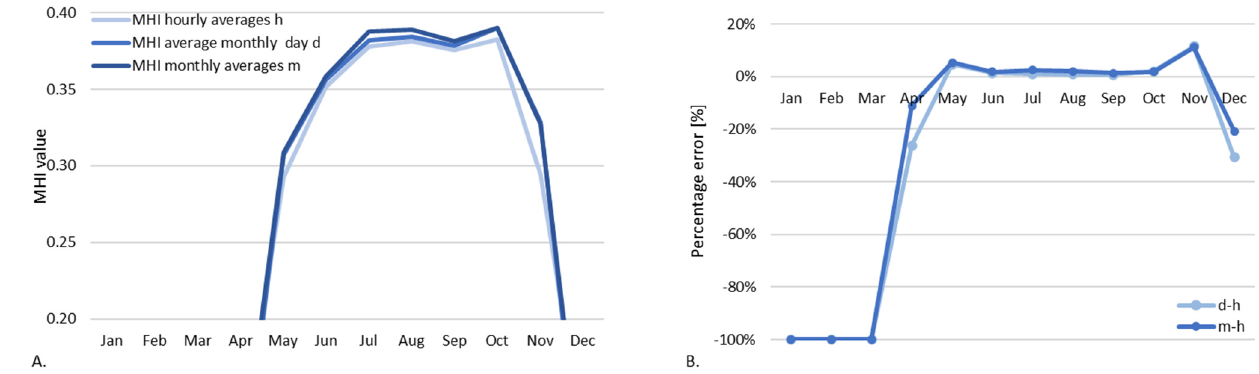
Figure 18. Paris MHI values ( A ) and percentage error ( B ).